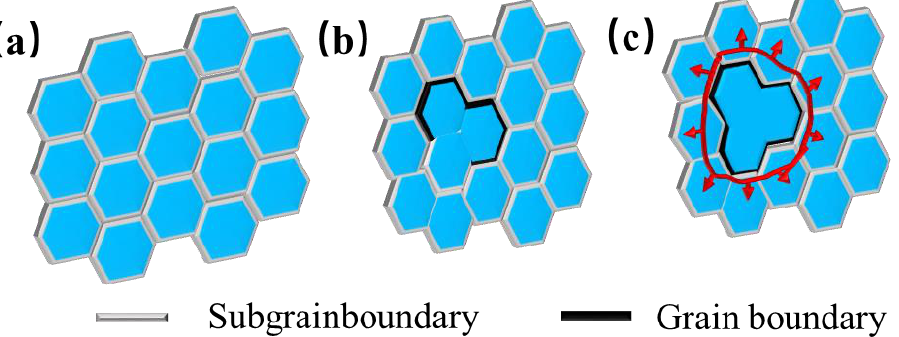
Figure 23. Molybdenum alloy recrystallization nucleation mechanism. ( a ) Subgrainboundary ( b ) Subgrainboundary merging ( c ) Grain boundary formation.